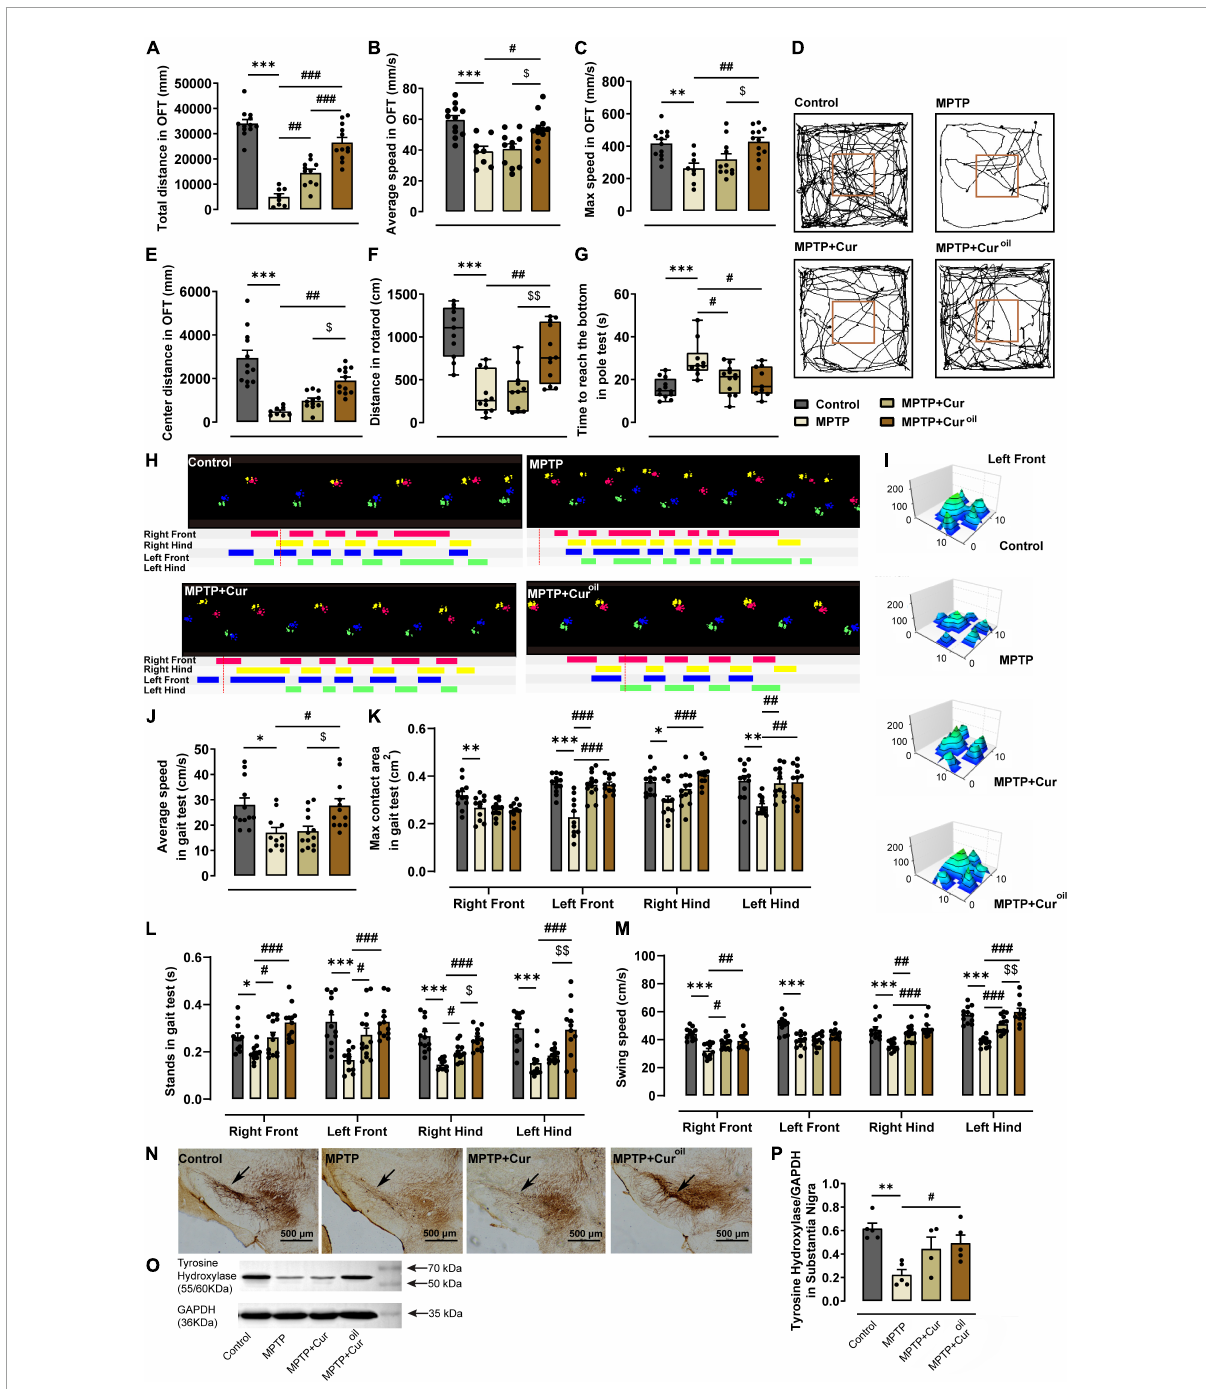
FIGURE2 The curcumin oil solution showed a better protective effect against MPTP-induced movement disorders and dopaminergic neuron degeneration in SNc. (A–C,E) The statistical results of the open-field test. (D) The representative movement paths in the open-field test from mice of each group. (F) The statistical results of the rotarod test. (G) The statistical results of the pole test. (H) The representative footprint track from mice of each group in the gait test. (I) The representative 3D view of the left front footprint from mice of each group in the gait test. (J–M) The statistical results in the gait test. (N) The representative figures of brain slice TH immunohistochemistry from mice of each group. The black arrows show the compact band of substantia nigra. (O) The representative protein expression bands from the western blot experiment. (P) The statistical result of the relative gray value of the protein bands in the western blot experiment. ∗ p < 0.05 compared to control group, ∗∗ p < 0.01 compared to control group, ∗∗∗ p < 0.001 compared to control group, # p < 0.05 compared to MPTP group, ## p < 0.01 compared to MPTP group, ### p < 0.001 compared to MPTP group, $ p < 0.05 compared to MPTP + Cur group, $$ p < 0.01 compared to MPTP + Cur